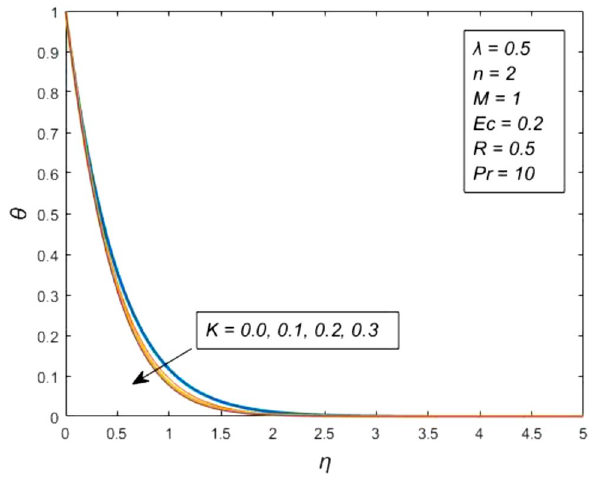
Figure 3. Impact of viscoelastic parameter K on the temperature profile.